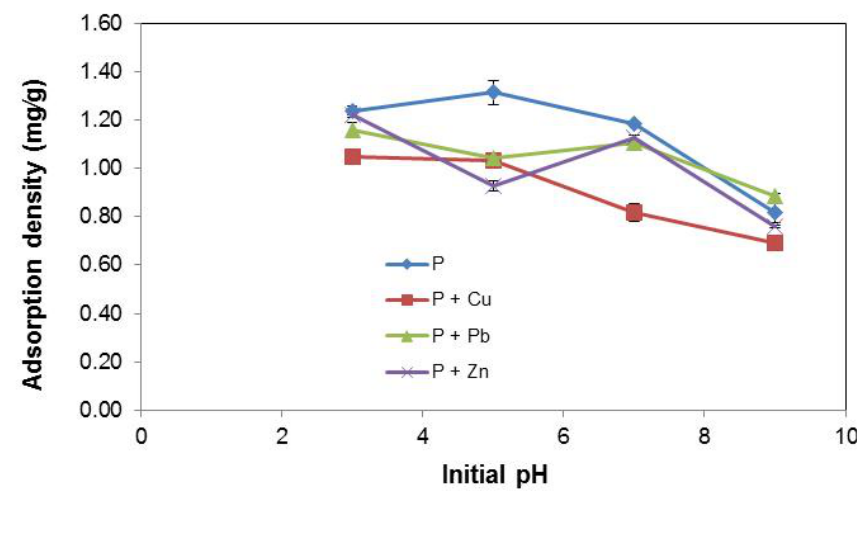
Figure 8. Effect of initial pH on P